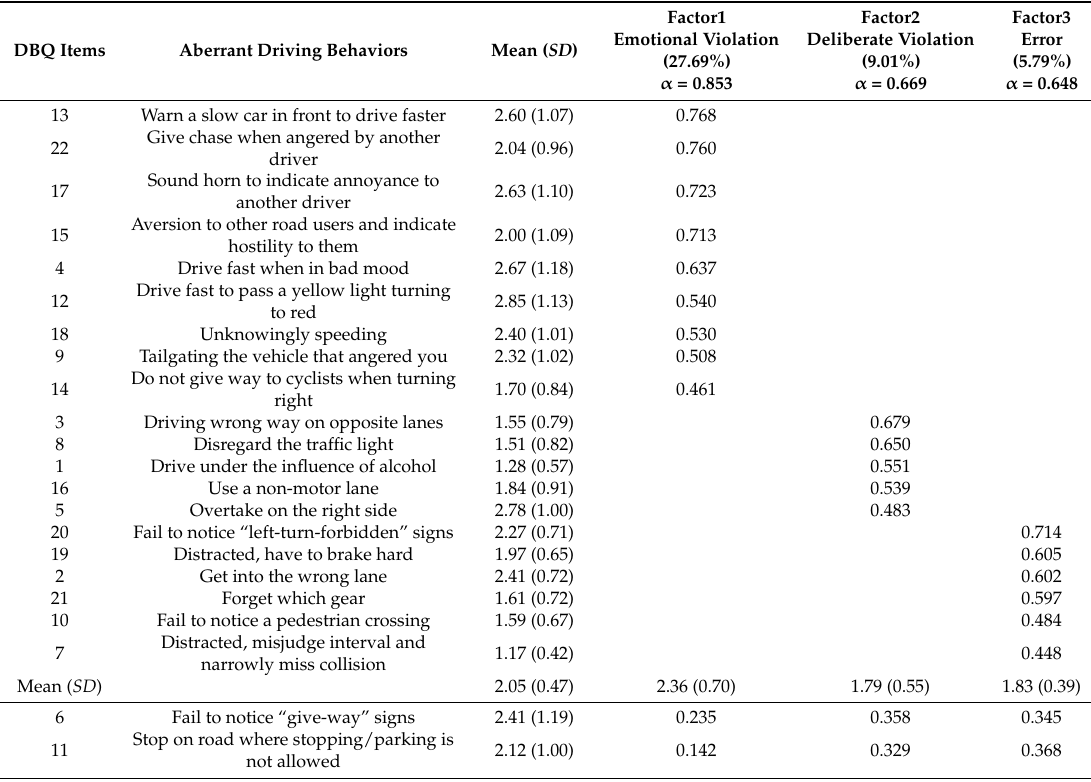
Table 3. Mean and standard deviation (SD) of each DBQ item and the results (number of factors determined, factor loading, etc.) of